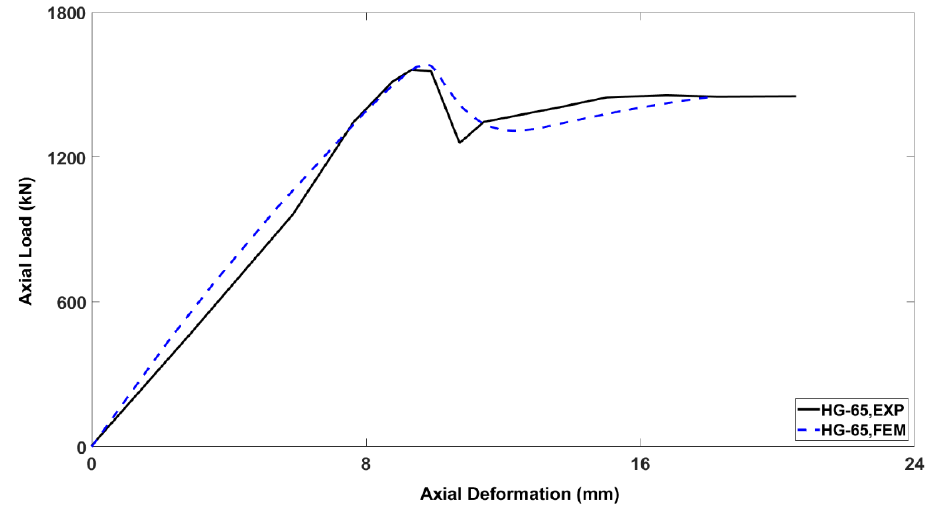
Figure 13. Axial load–axial deformation curves of control specimen (HG-65).